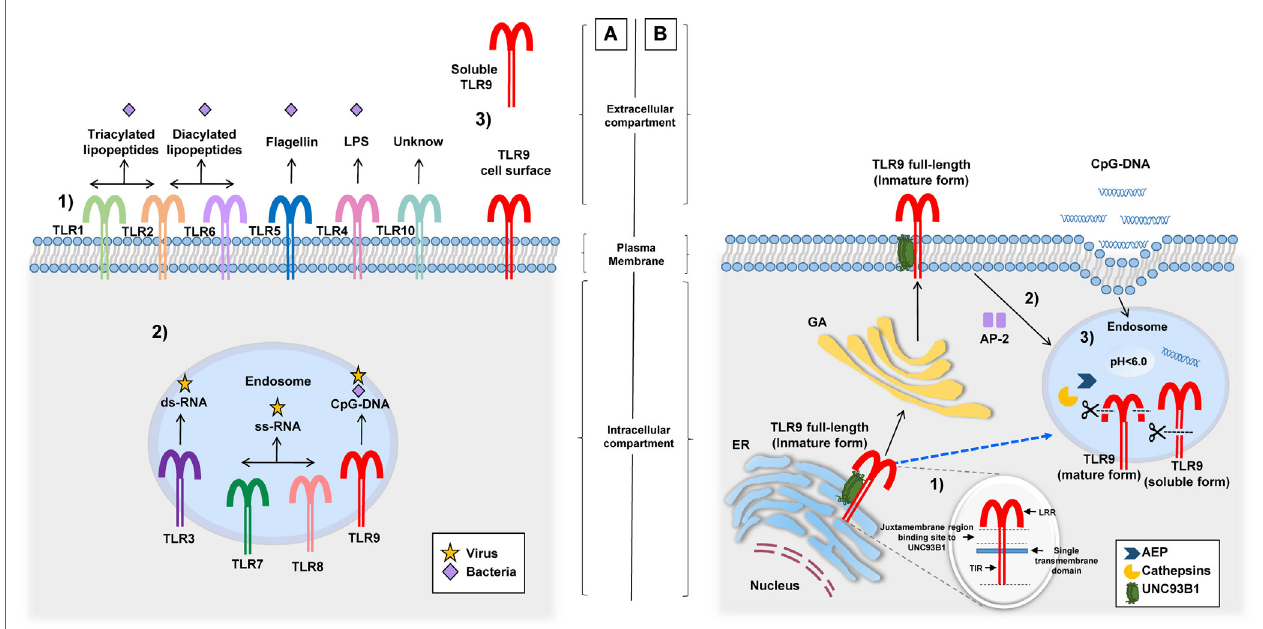
FiGUre 1 | Different locations of TLRs and the TLR9 signaling route. (A) (1) TLRs (and their respective ligand) expressed on the cell surface: TLR1/TLR2 (triacylated lipopeptides), TLR2/TLR6 (diacylated lipopeptides), TLR5 (flagellin), TLR4 (LPS), and TLR10 (unknown). (2) TLRs expressed in endosomes: TLR3 (ds-RNA), TLR7/ TLR8 (ss-RNA), and TLR9 (CpG-DNA). (3) TLR9 cell surface expression related to their signaling route and soluble form identified in pleural effusions and HEK 293 cells, although its production and functions are unknown. (B) Before TLR9 is located inside the endosome, it can be identified in the ER, the GA, and lysosomes. (1) Inside the ER, the juxtamembrane region of TLR9 interacts with UNC93B1, a facilitator protein that allows the exit of TLR9 toward the cell surface or directly to endosomes (dotted blue line). (2) Once on the cell surface, TLR9 becomes associated with AP-2 for cell internalization through the interaction with phagosomes or endosomes. (3) In this location, TLR9 modifies its structure by the action of AEP and cathepsins generating a mature form (80 kDa) and a soluble form (100 kDa) without transmembrane and TIR domains, this form is retained in the endosome and prevents the activation of TLR9. Abbreviations: ER, endoplasmic reticulum; GA, Golgi apparatus; LPS, lipopolysaccharide; HEK 293, human embryonic kidney 293; UNC93B1, unc-93 homolog B1; AP-2, adaptor protein complex 2; AEP, asparagine endopeptidase; TLR9, toll-like receptor 9; TIR, toll-interleukin 1 receptor; LRR, Leucine-rich